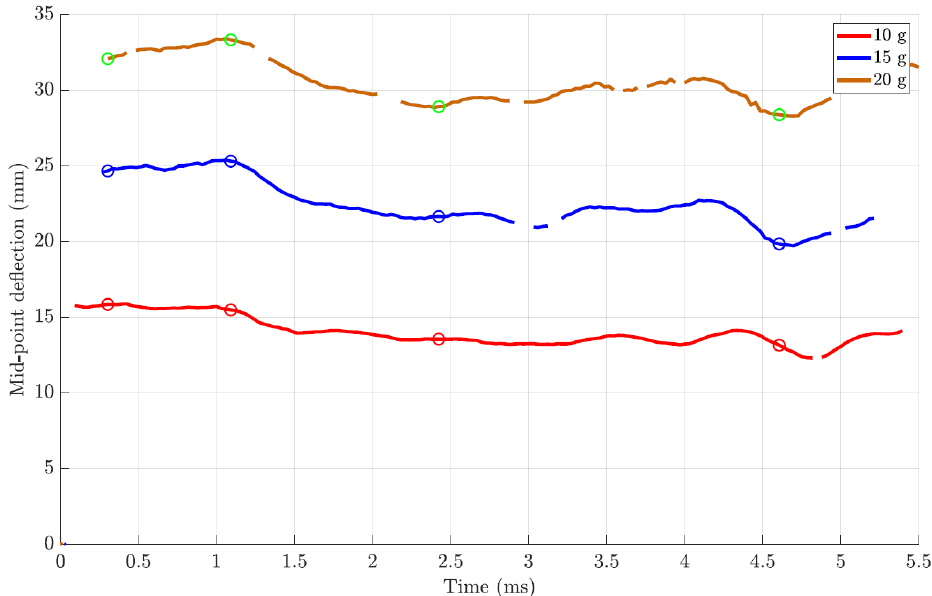
Figure 14. Graph of transient midpoint displacement versus time obtained from the blast tests on 105° V-structures with a 32 mm tip radius.